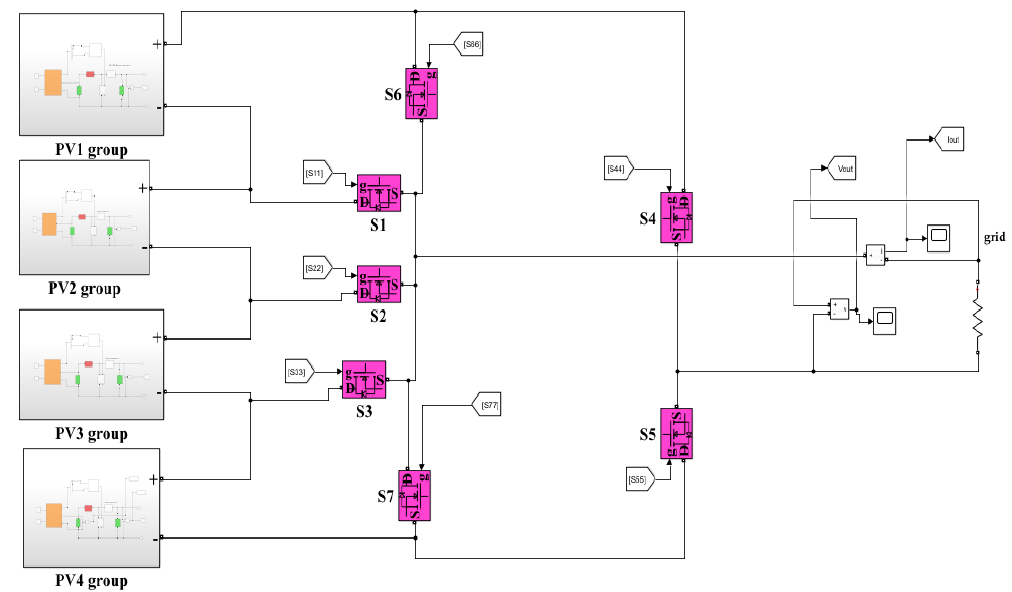
Figure 19. Simulation diagram of the proposed nine-level, seven-switch topology.